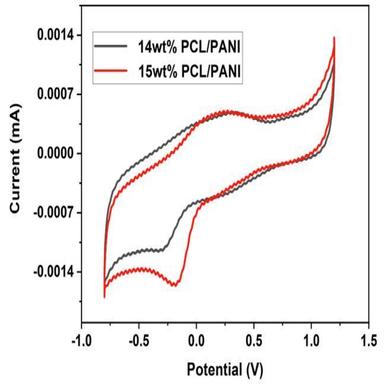
Lowest scan rate CV comparison graph at 10 mV/s.